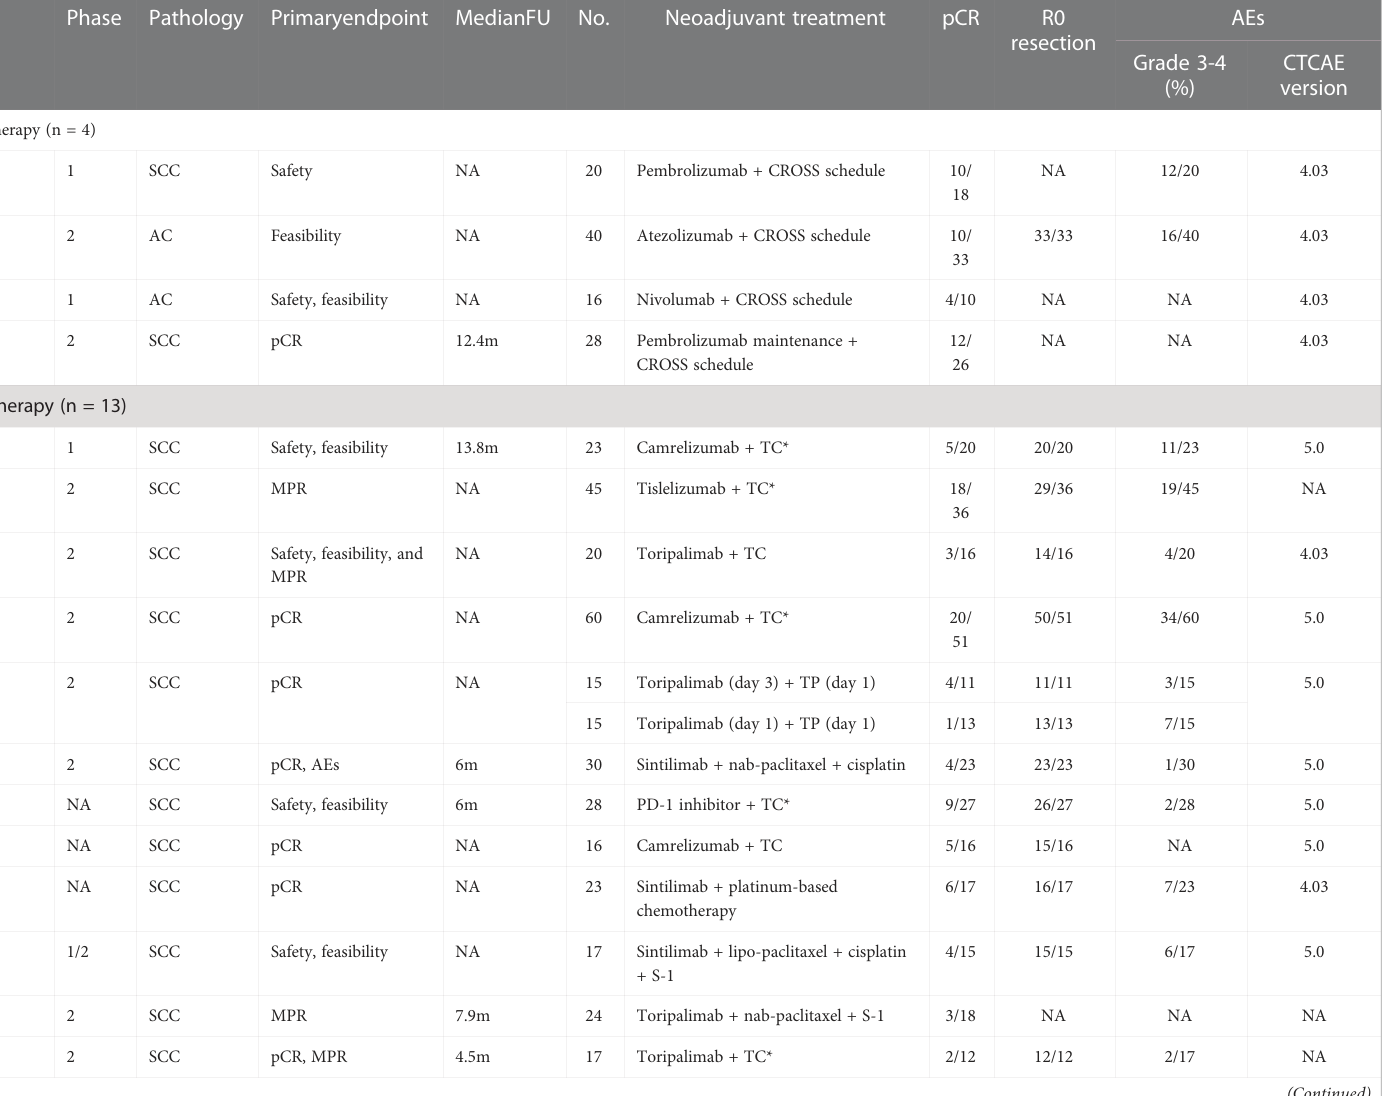
TABLE 1 Summary of the trials of neoadjuvant immunotherapy for resectable esophageal or gastroesophageal junction carcinoma.